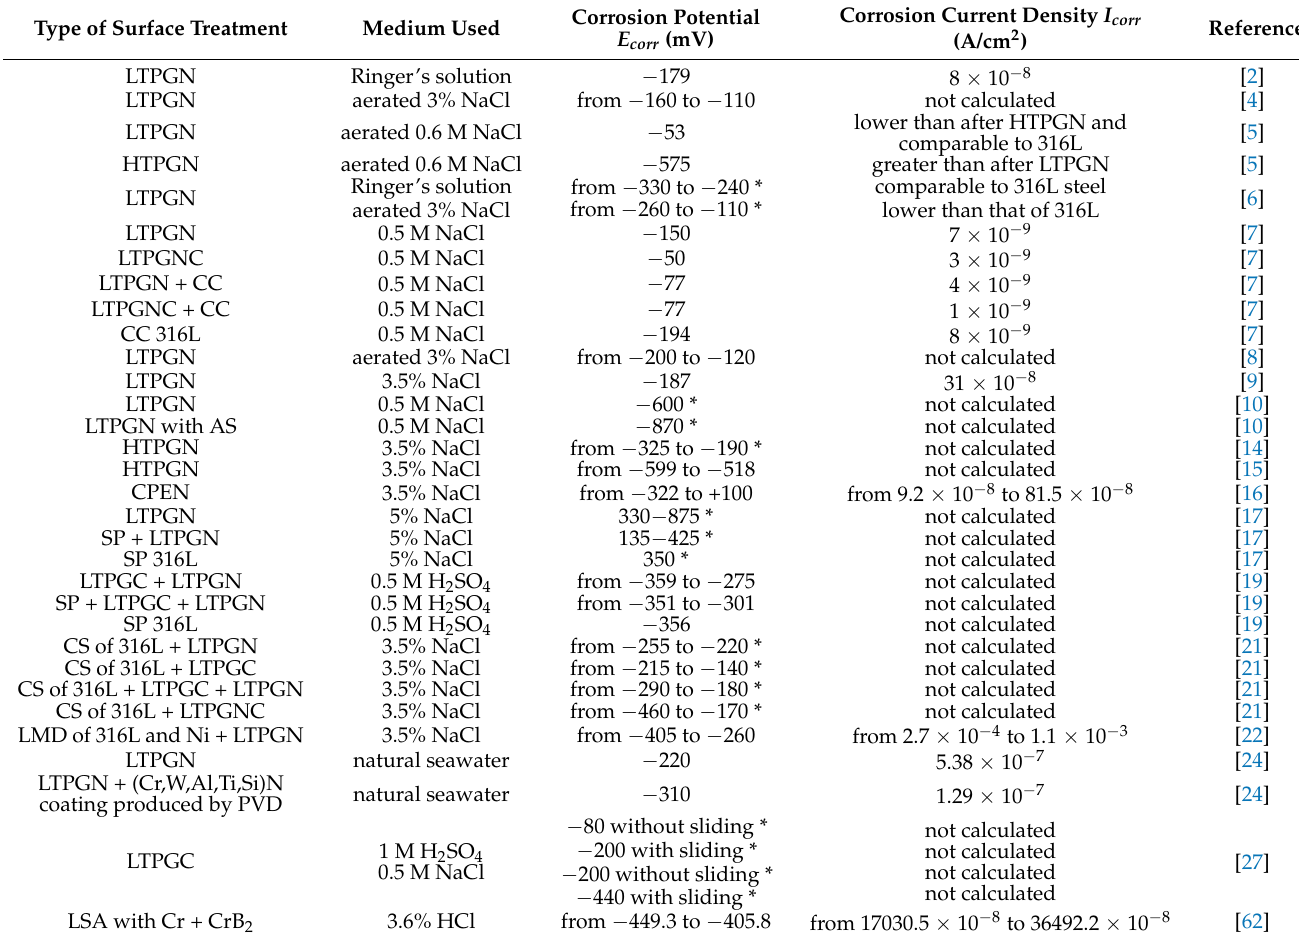
Table 10. Corrosion potential E corr and corrosion current density I corr of surface layers, produced in 316L austenitic steel using other physical techniques. Type of Surface